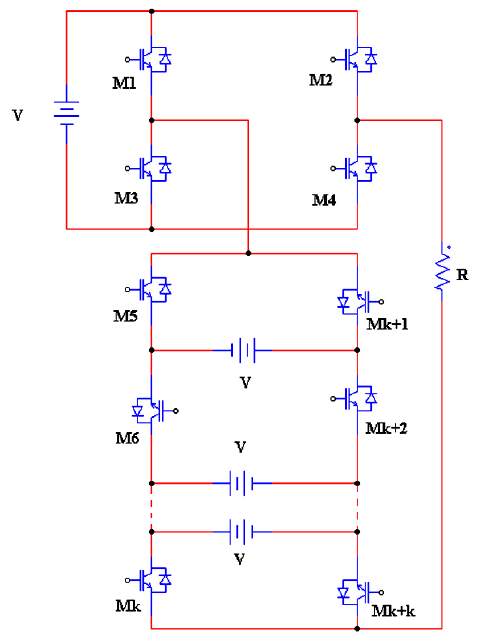
Figure 34. Circuit diagram for hybrid MLI.